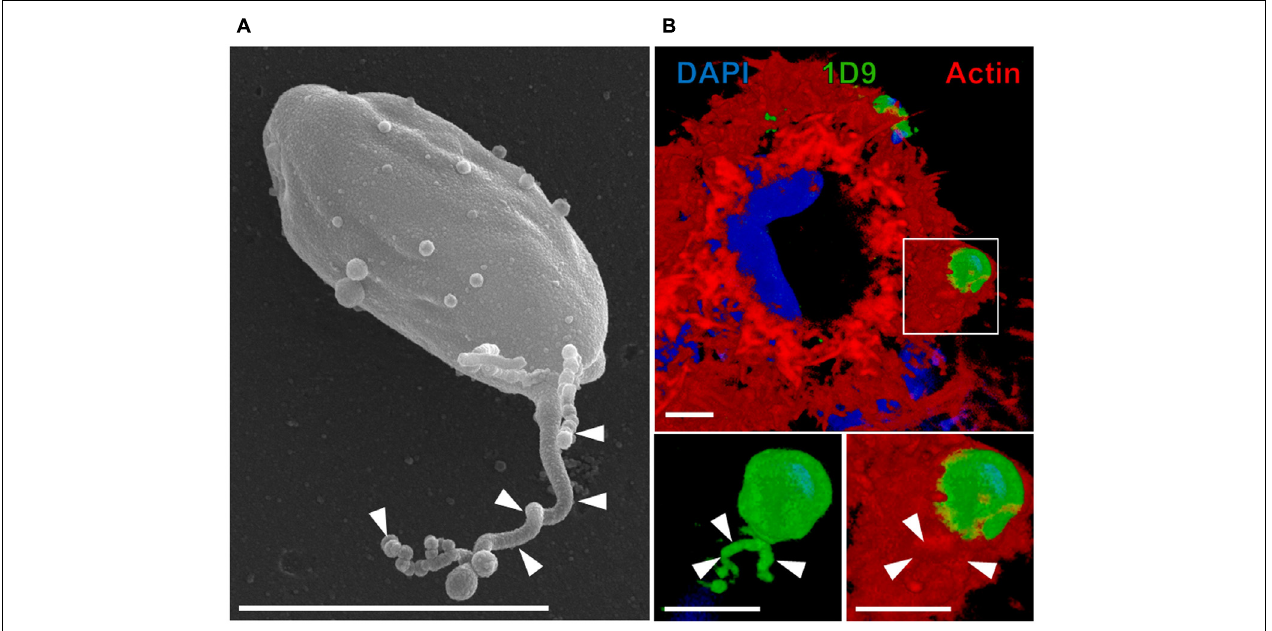
FIGURE 1 | Extracellular amastigotes (EAs) of T. cruzi release microvesicles over cellular or non-cellular surfaces. (A) EAs can release microvesicles trails (arrowhead) over acellular surfaces such as uncoated transwell membrane (scanning electron microscopy) (Florentino et al., 2018). (B) EAs can also secrete microvesicle trails over HeLa cells (Florentino et al., 2018). In this particular interaction, microvesicle trails (arrowheads) were secreted inside the actin-rich cup-like structure induced on the surface of HeLa cells by the EA (3D rendering of confocal microscopy acquisition). Blue: DAPI (4 (cid:48) ,6-diamidine-2 (cid:48) -phenylindole dihydrochloride; nuclei and kinetoplasts); green: 1D9 antibody (surface of EAs and microvesicles); red: phalloidin-TRITC (tetramethyl-rhodamine isothiocyanate; actin filaments of HeLa cells) (Florentino et al., 2018). Bars = 3 µ